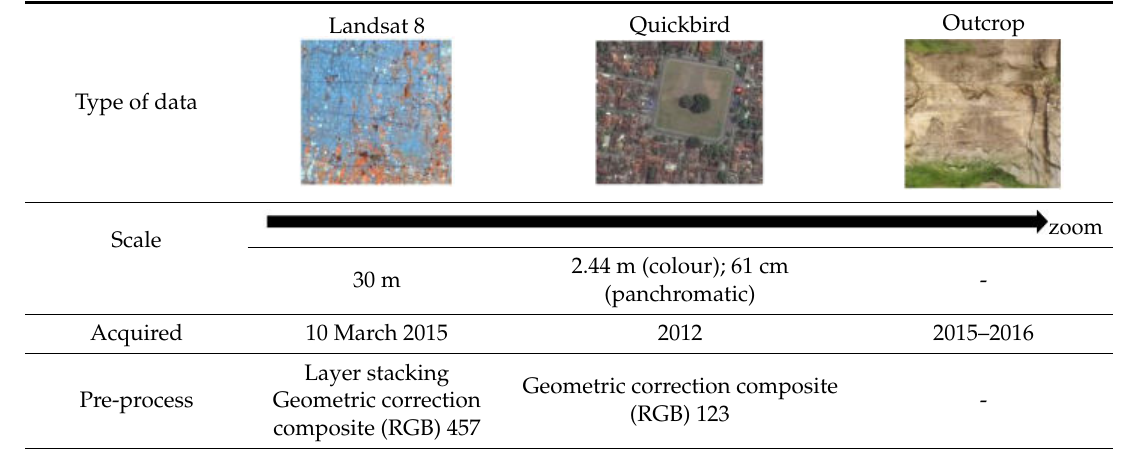
Table 2. The summary of the data used in the